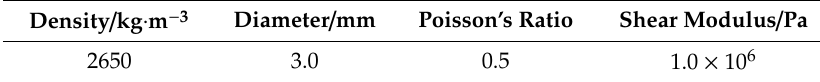
Table 3. Physical properties of corundum particles.